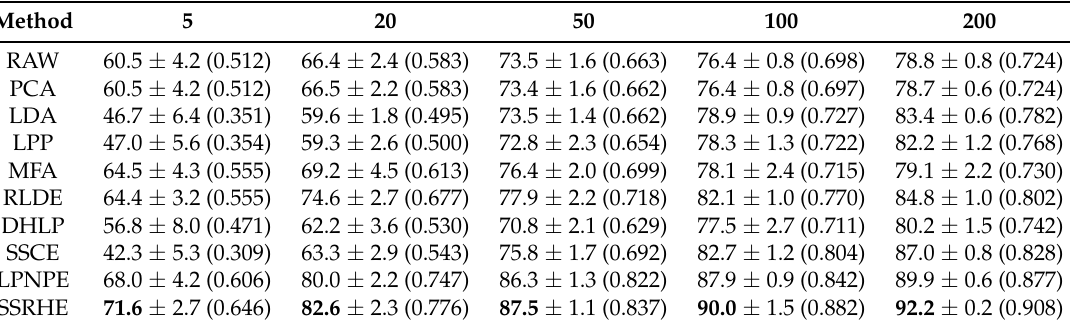
Table 2. Classification results using different methods with different classifiers for the PaviaU dataset. (OA ± STDs (%) ( KC )).